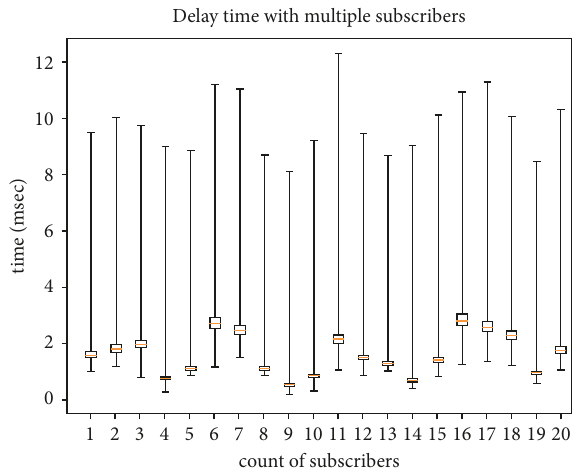
Figure 7: Paho+Mosquitto MQTT’s delay boxes with different subscriber counts.